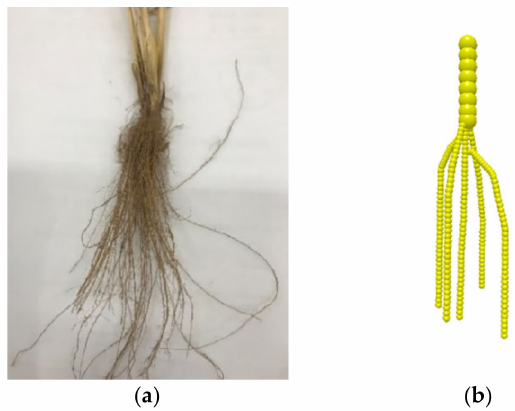
Figure 9. Discrete element model of Cyperus esculentus root system. ( a ) Cyperus esculentus root system model; ( b ) discrete element modeling of Cyperus esculentus .